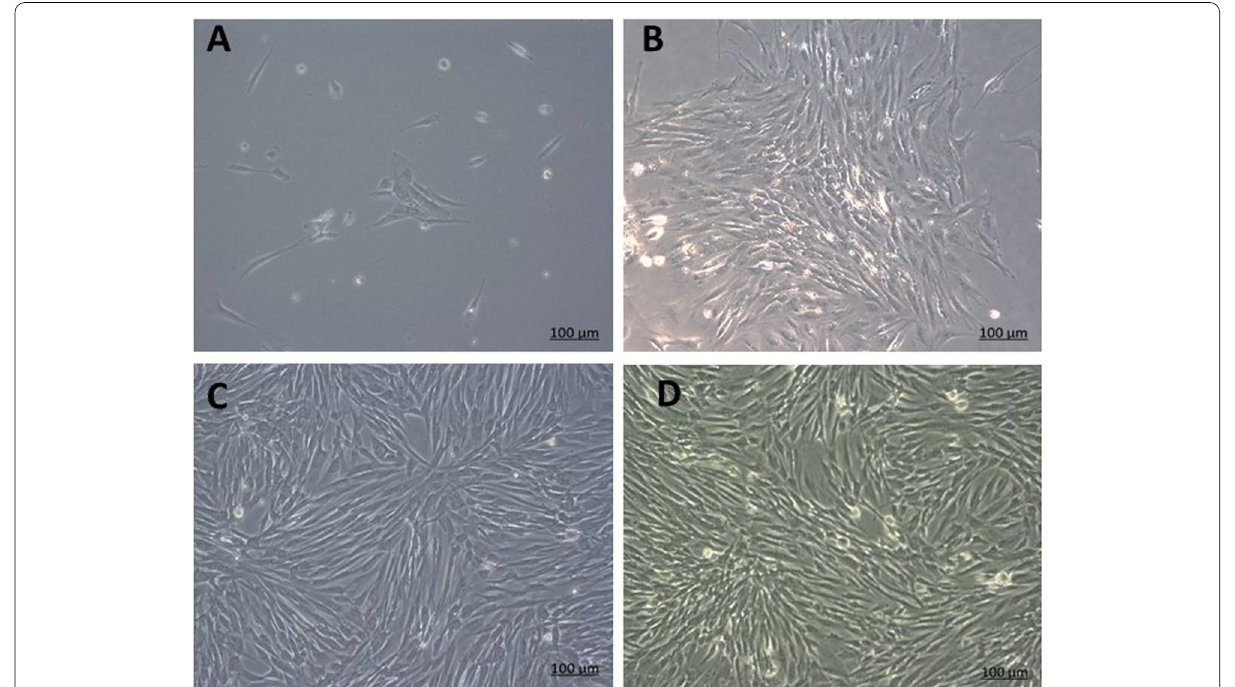
Fig. 2 Photomicrograph illustrating the morphological changes of hDPSCs & hPDLSCs following isolation. In both cultures of hDPSCs and hPDLSCs after approximately 3 days of culture, scattered single cells started to attach to the culture plate assuming a spindle‑shaped appearance ( A ). Gradually, these spindle‑shaped cells started to increase in number, and colonies were evident by day 5 of culture ( B ). These colonies increased in size and reached 80% confluence by the 10th day of culture in hDPSCs ( C ) and by day 15 in hPDLSCs ( D ) (scale bar